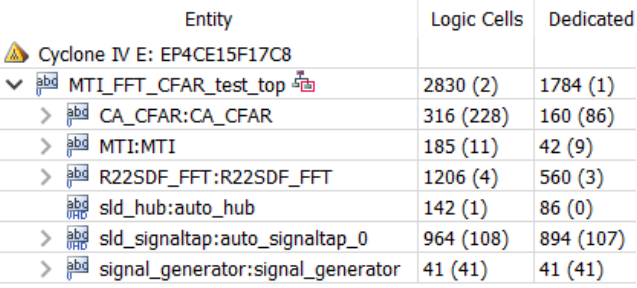
Figure 19. Occupancy of FPGA resources for moving target detection.